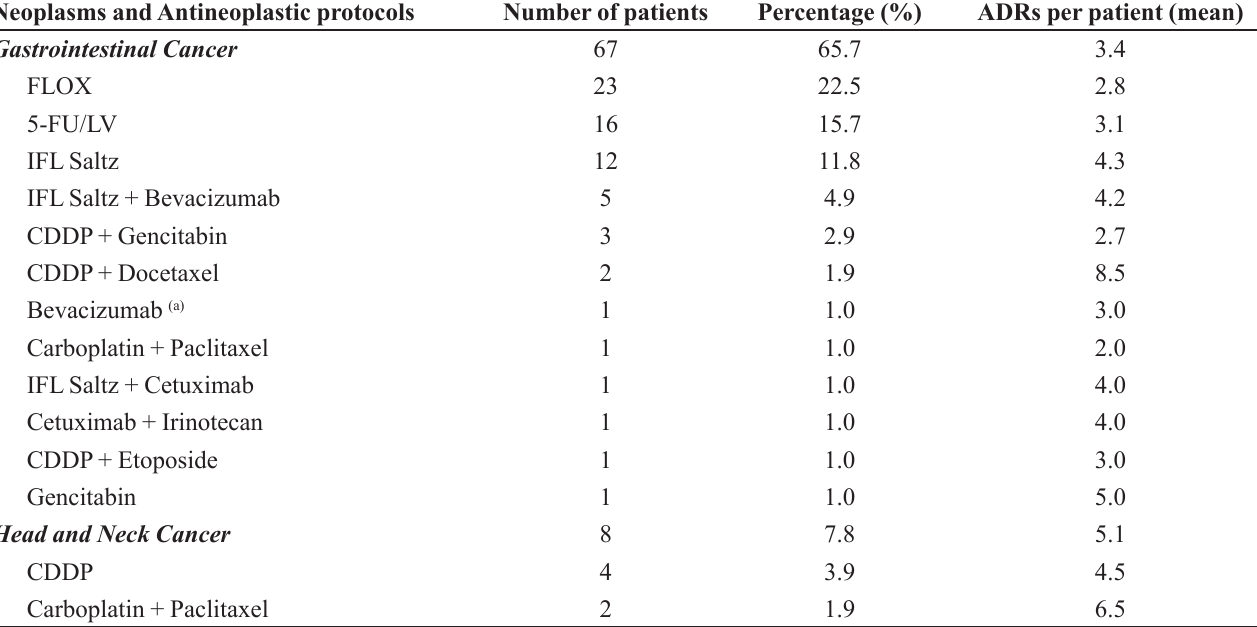
TABLE III - Neoplasms, antineoplastic protocols, and adverse drug reactions (ADRs) of outpatients interviewed in the Chemotherapy Clinic from October to November